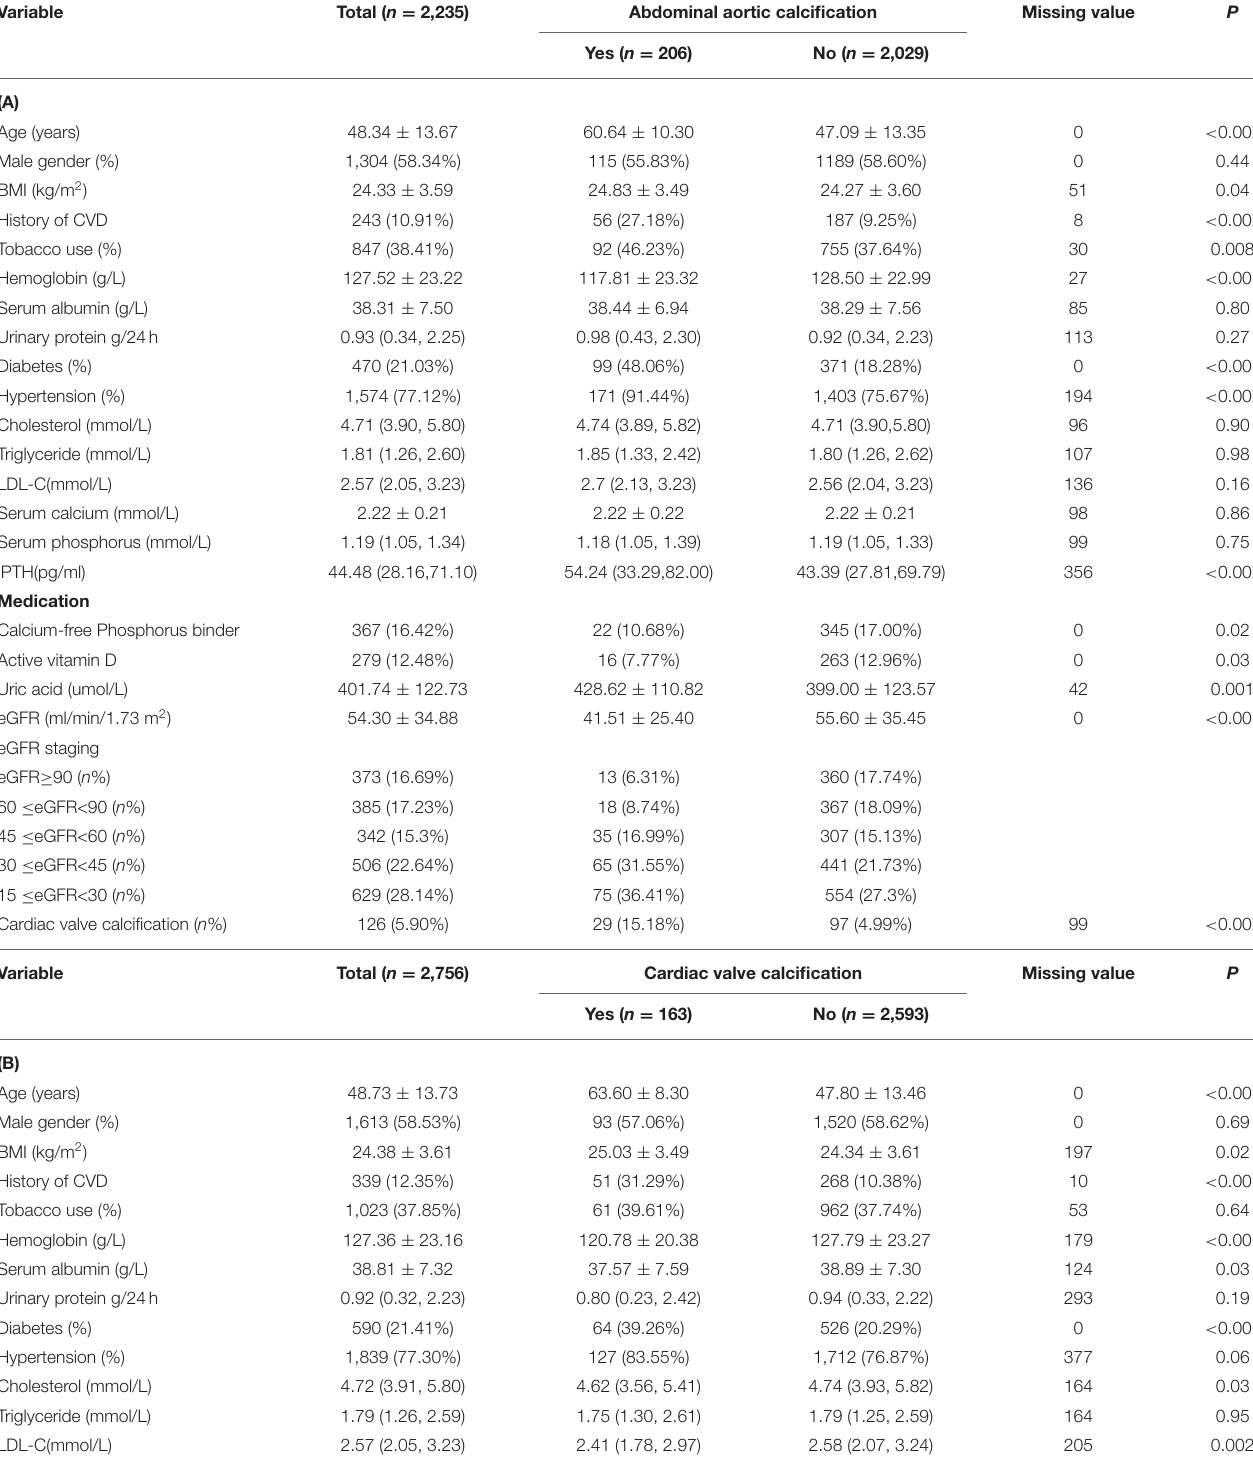
TABLE 1 | (A) Characteristics of patients with non-dialysis CKD Stages 1–4 with and without AAC at baseline. (B) Characteristics of patients with non-dialysis CKD Stages1 to 4 with and without CVC at baseline.